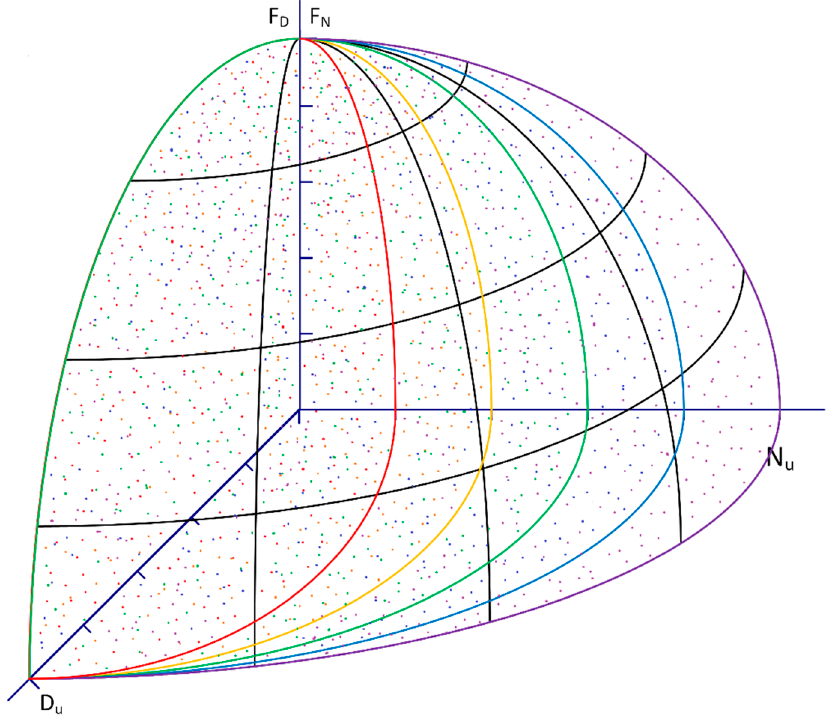
Figure 3. Deterministic Monte Carlo sampling from within the possibility space.